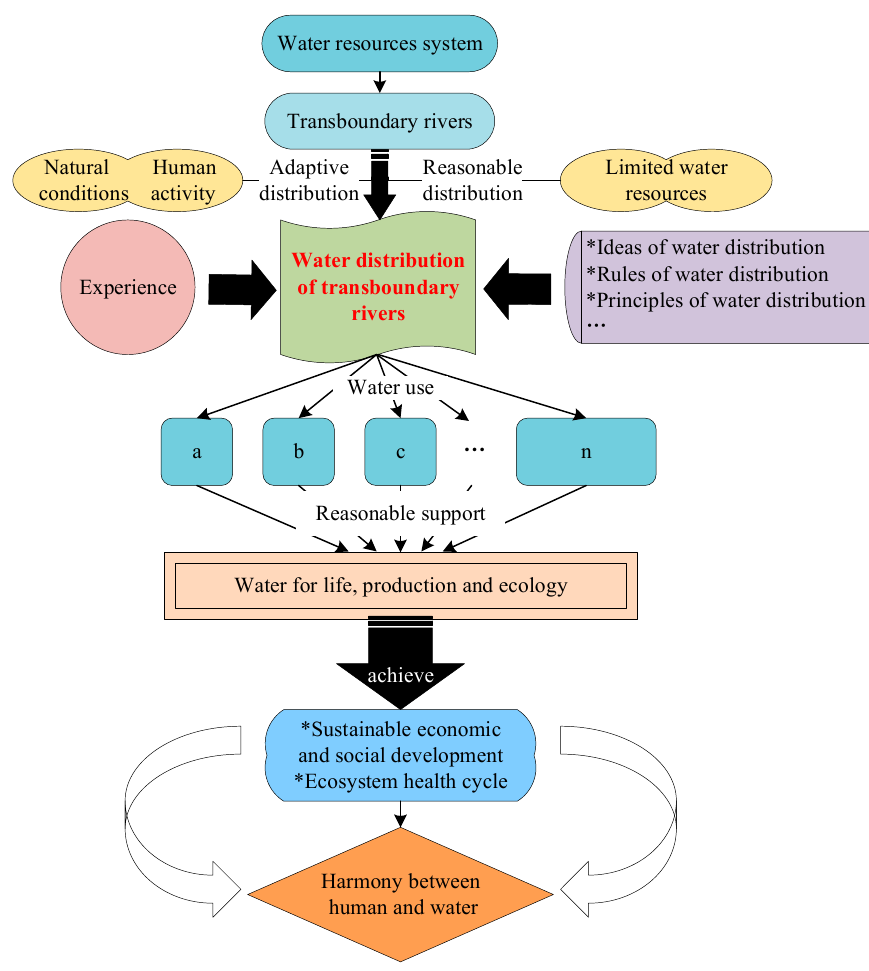
Figure 2. A schematic diagram of water distribution principles of transboundary